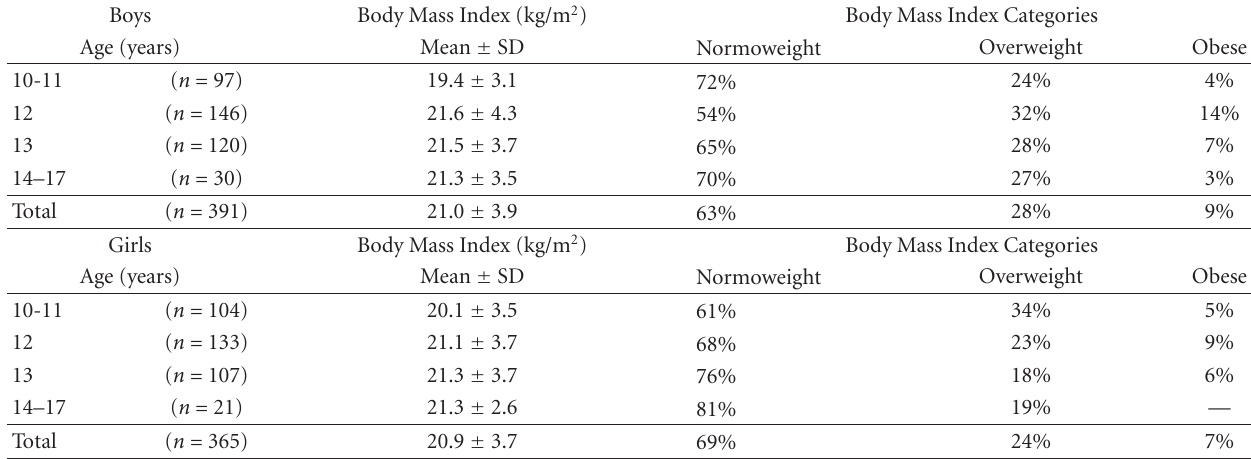
Table 1: Prevalence of normoweight, overweight and obesity in boys and